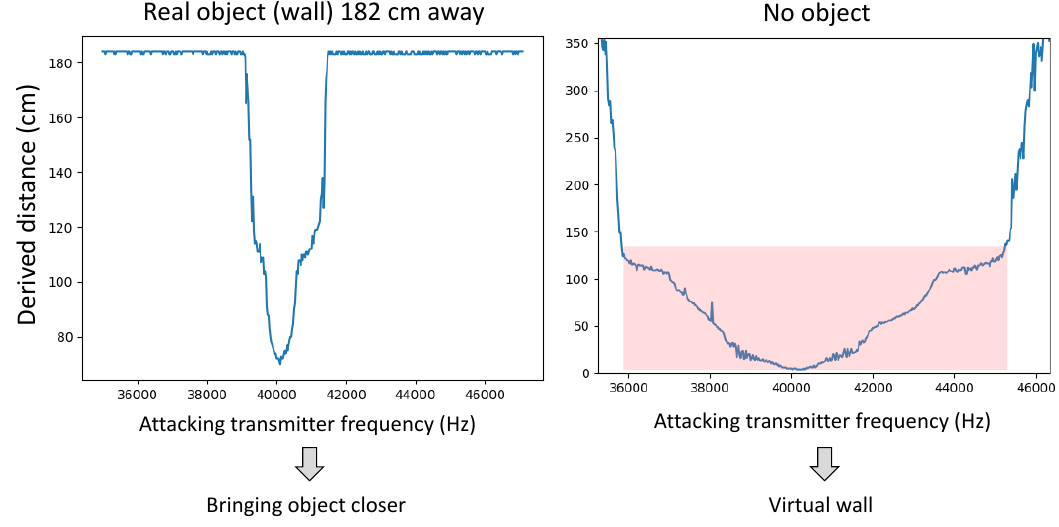
Figure 5. Transmitting a constant signal with a changing frequency.